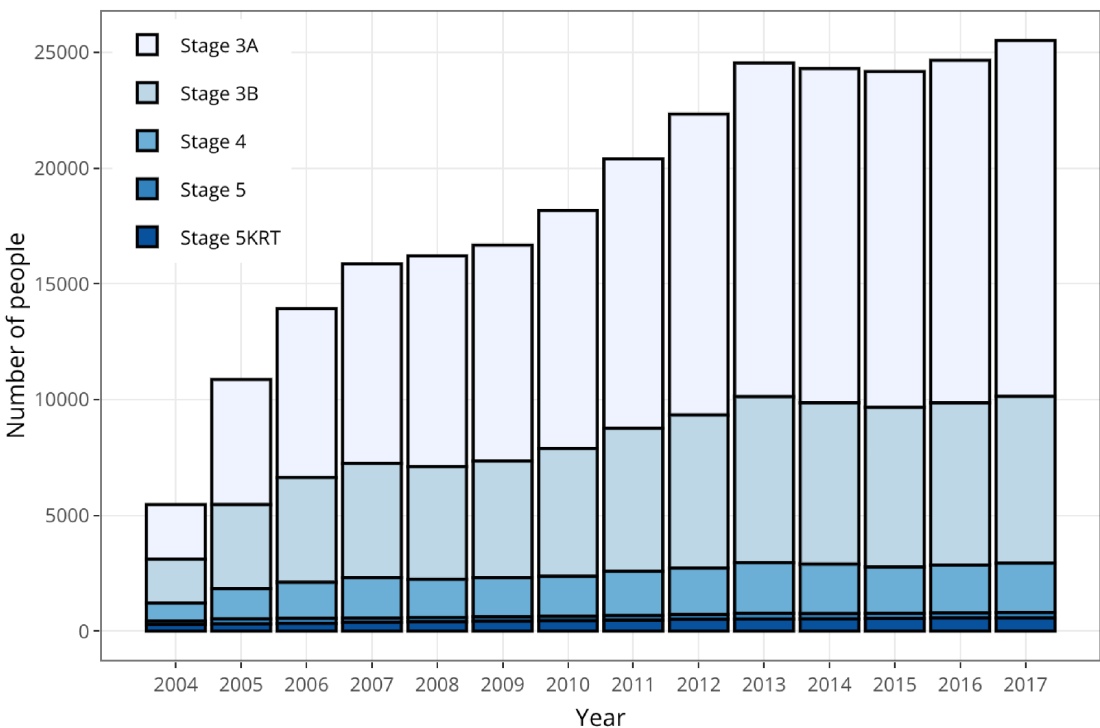
Figure 4: Prevalence per year by CKD Stage